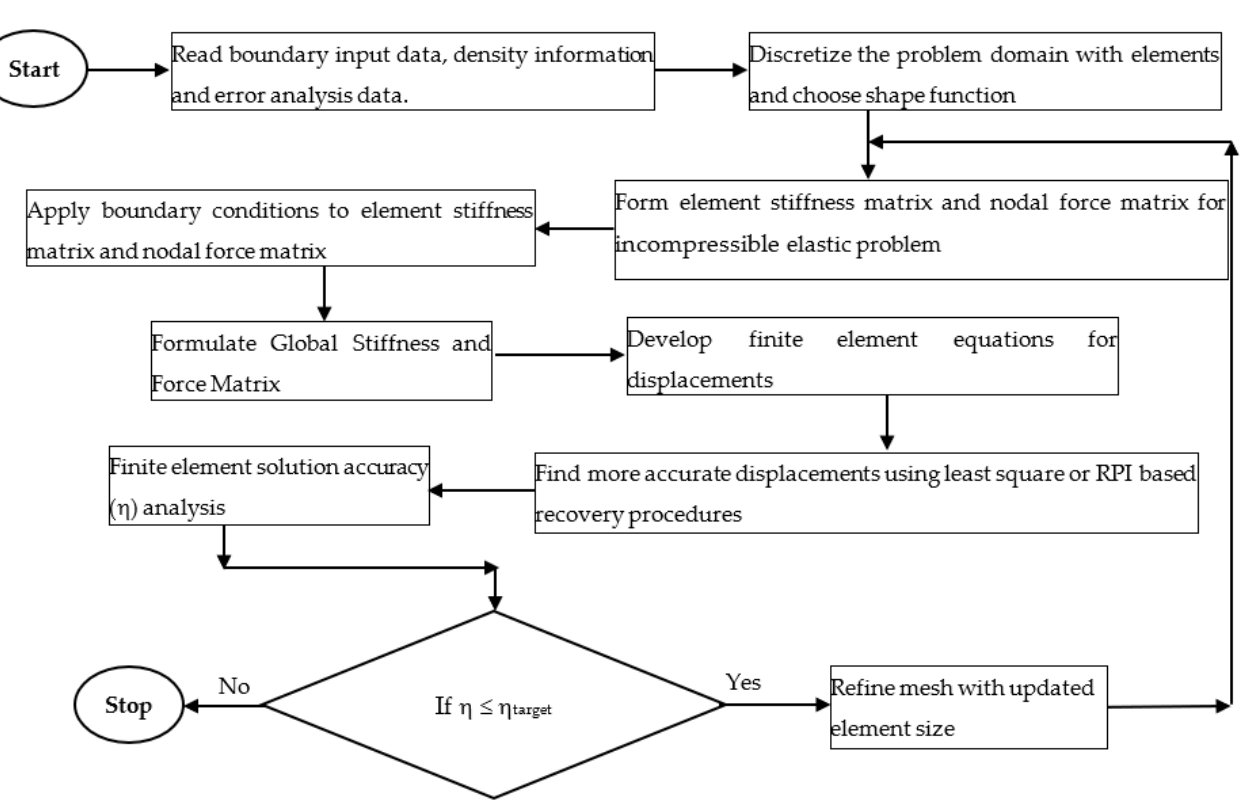
Figure 1. Flow chart for adaptive finite element analysis of the incompressible-elasticity problem using least-square and RPI-based recovery techniques.